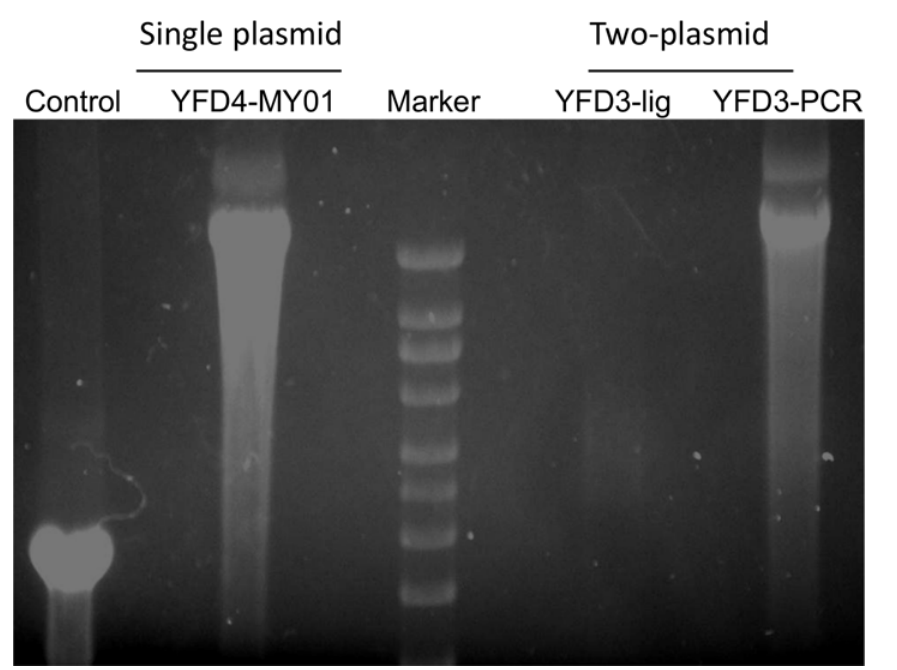
Fig 2. RNA transcripts from LONG-PCR template. In vitro transcription reactions were performed using DNA templates from single-plasmid or two-plasmid (ligation/non-PCR and ligation/LONG-PCR) constructs. Equal volume aliquots of RNA transcripts produced were denatured at 50 0 C for 30 minutes and then were electrophoresed on a 1% denaturing glyoxal gel. Control lane indicates RNA transcript produced from the control DNA template included in the in vitro transcription